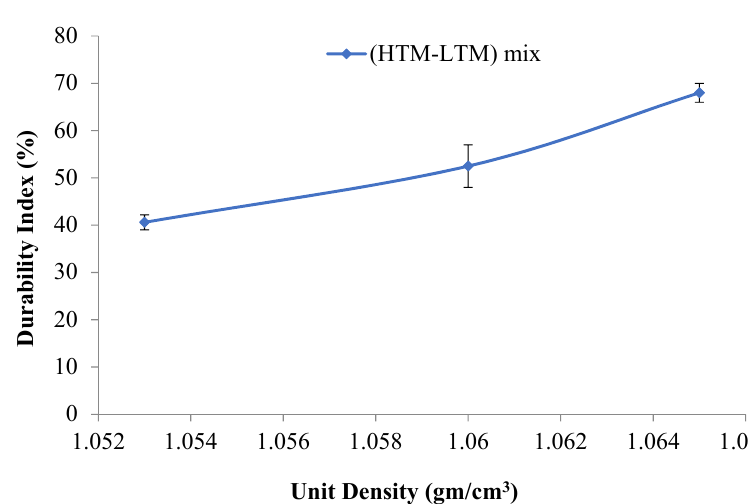
Bioengineering 2019 , 6 , 87 Figure 14. Linear correlation between mechanical durability and unit density. Figure 14. Linear correlation between mechanical durability and unit density.